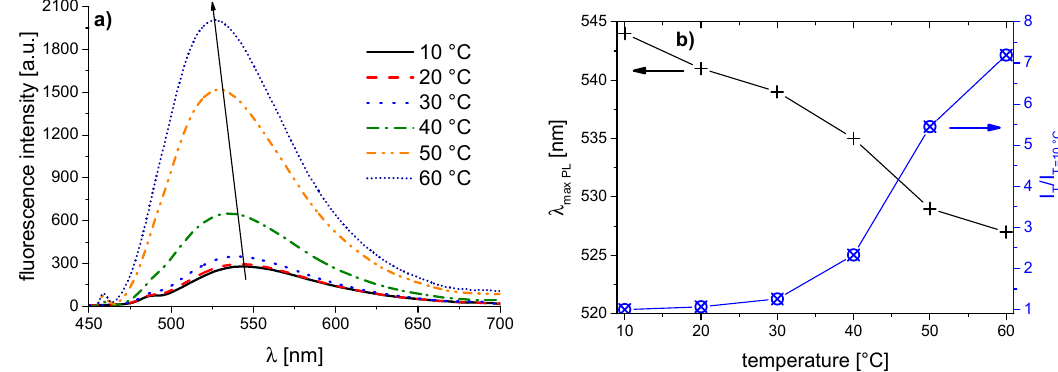
Figure 8. Temperature dependent fluorescence behavior of PNVCL-d in aqueous solution (concentration 0.10 g·L − 1 ): ( a ) normalized emission spectra ( λ Exc = 418 nm); and ( b ) evolution of λ maxEm of the emission band, and of the fluorescence intensity normalized to 10 °C.